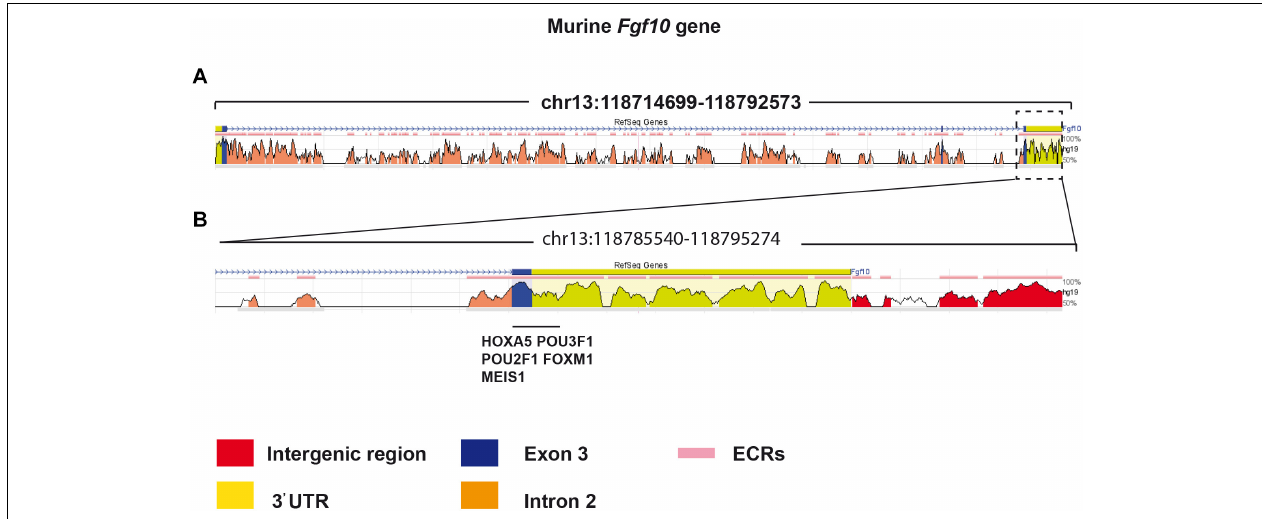
FIGURE 7 | Bioinformatic analysis identified potential transcriptional factors binding sites in the 3 (cid:48) UTR of Exon 3. (A) The murine Fgf10 gene is made of 3 exons. (B) High magnification of Exon 3 and the associated 3 (cid:48) UTR. Several putative important transcriptional factor binding sites were found in this region.